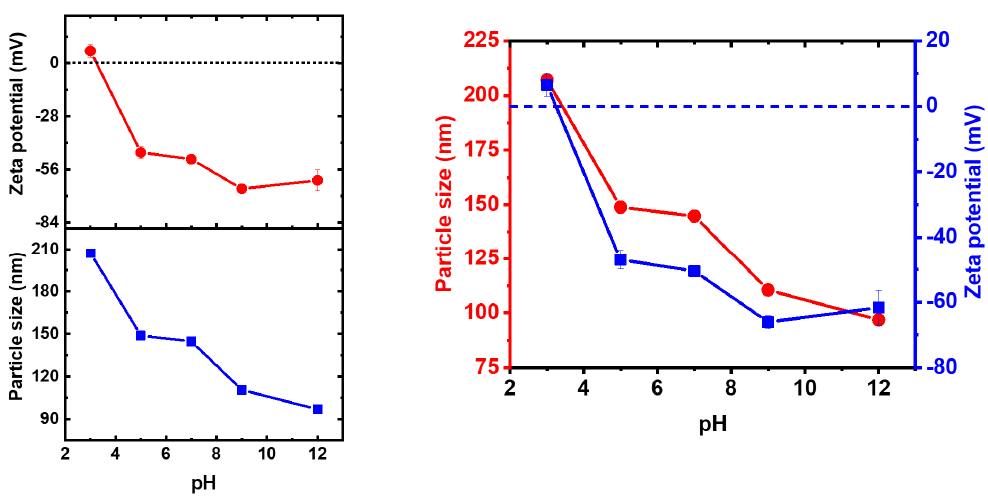
Figure 7. DLS graph and zeta potential ( ζ ) of AuNPs as a function of pH, ranging from 3 to 12.